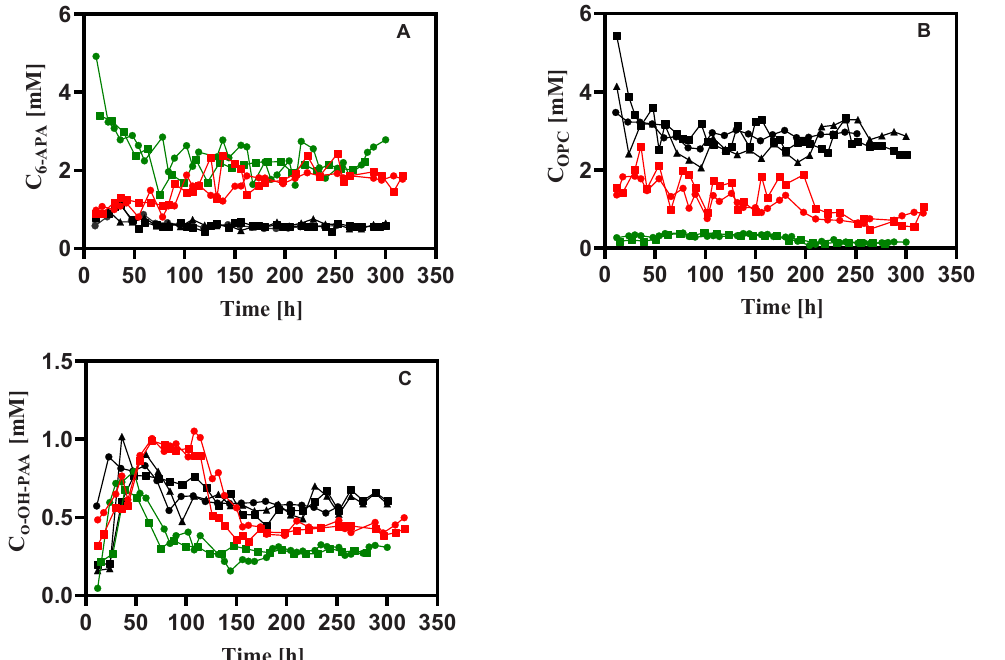
Figure 4. Measured concentrations of ( A ) 6-APA, ( B ) OPC and ( C ) o-OH-PAA during rapid feast/famine conditions throughout the chemostat phase. Penicillium chrysogenum ∆ tps1 and Penicillium chrysogenum ∆ tps2 , respectively. Time 0 represents the start-up of chemostat cultivation. Abbreviation: 6-APA, 6-aminopenicillanic acid; OPC, 6-oxopipeidine-2- carboxylic acid; o-OH-PAA, ortho-hydroxyphenyl acetic